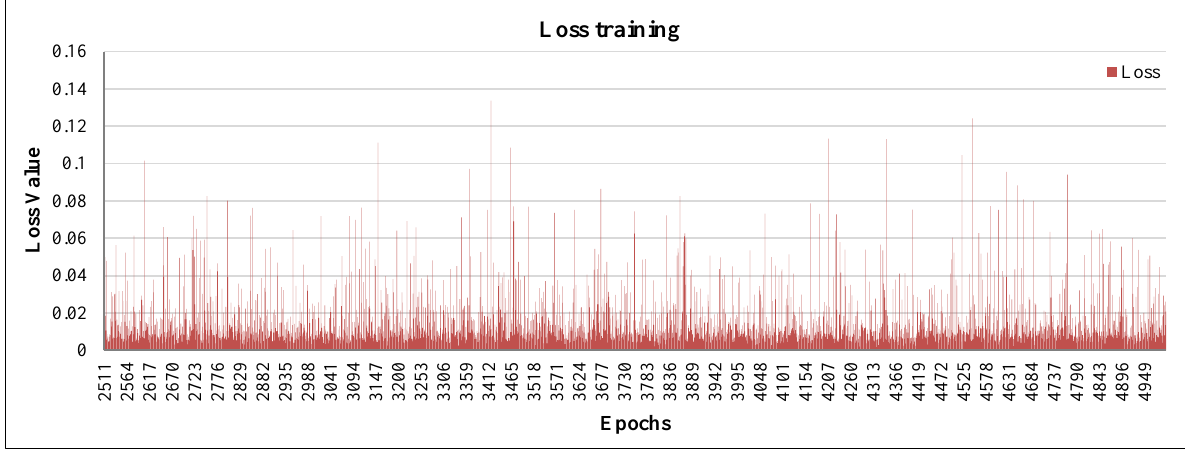
Figure 5. Graphics Loss